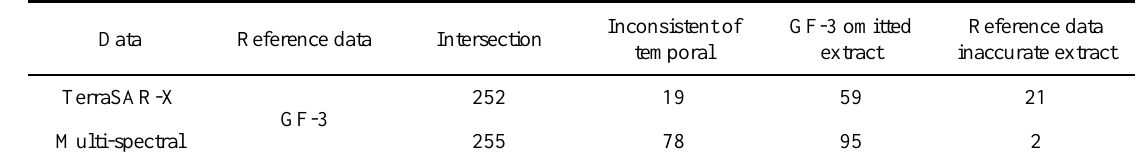
Table 11. Differential Analysis of reference data and GF-3 data